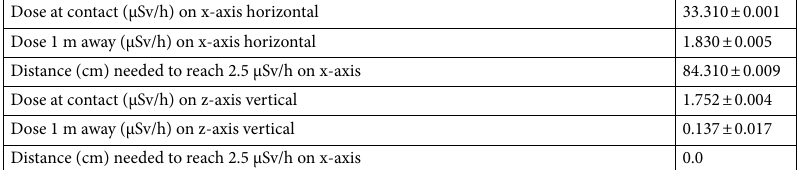
Dose at contact (μSv/h) on x-axis horizontal 33.310 ± 0.001 Dose 1 m away (μSv/h) on x-axis horizontal 1.830 ± 0.005 Distance (cm) needed to reach 2.5 μSv/h on x-axis 84.310 ± 0.009 Dose at contact (μSv/h) on z-axis vertical 1.752 ± 0.004 Dose 1 m away (μSv/h) on z-axis vertical 0.137 ± 0.017 Distance (cm) needed to reach 2.5 μSv/h on x-axis Table 2. Data for decision-making process based on Monte Carlo simulation in view to achieve public exposure condition in the boundary adjacent areas to the DSRSs container. Public exposure here refers to the ALARA principle of less than 1 mSv/year, which in other words means 2.5 μSv/h.